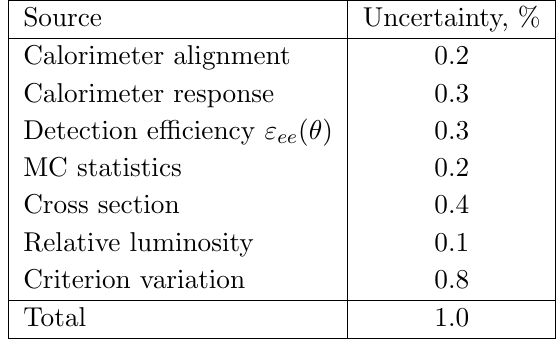
Table 2 . Systematic uncertainties of the luminosity determination in